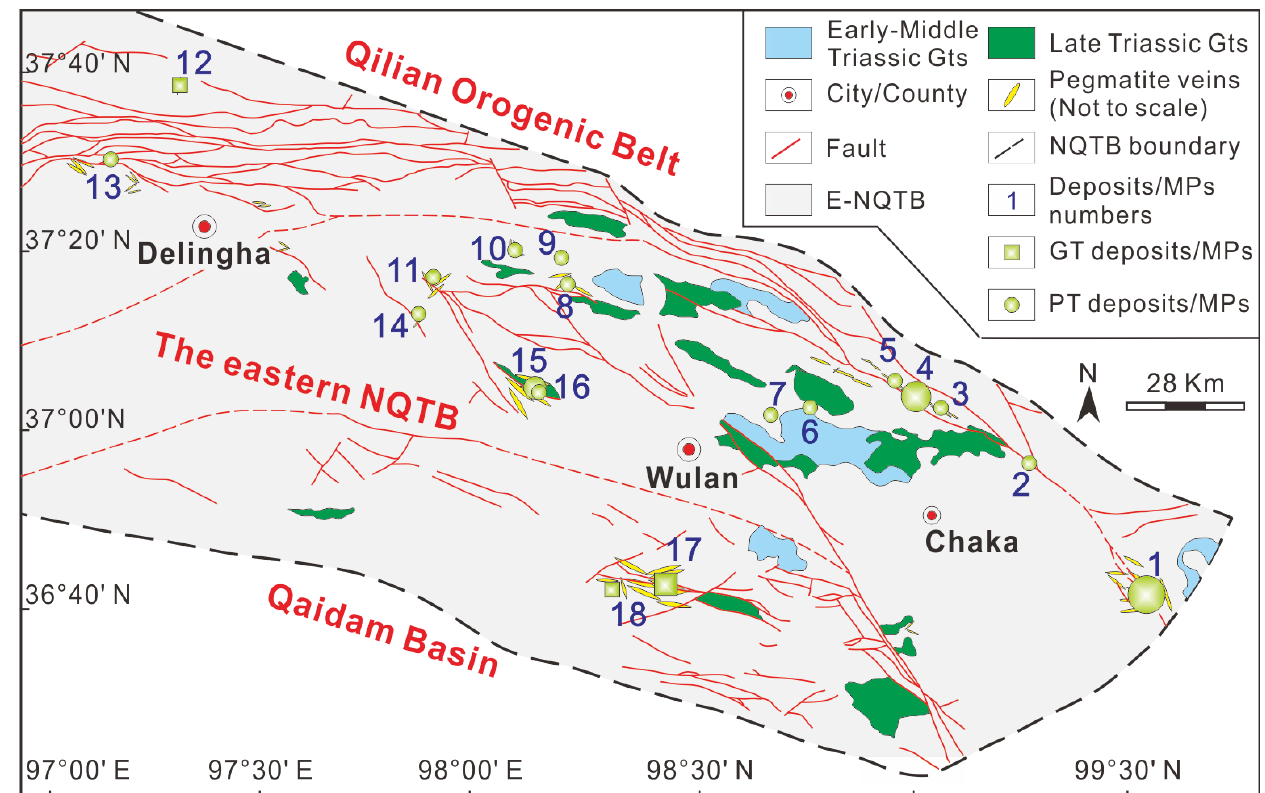
Figure 11. Geological sketch of Triassic granitoids and rare-metal deposits in the eastern NQTB.